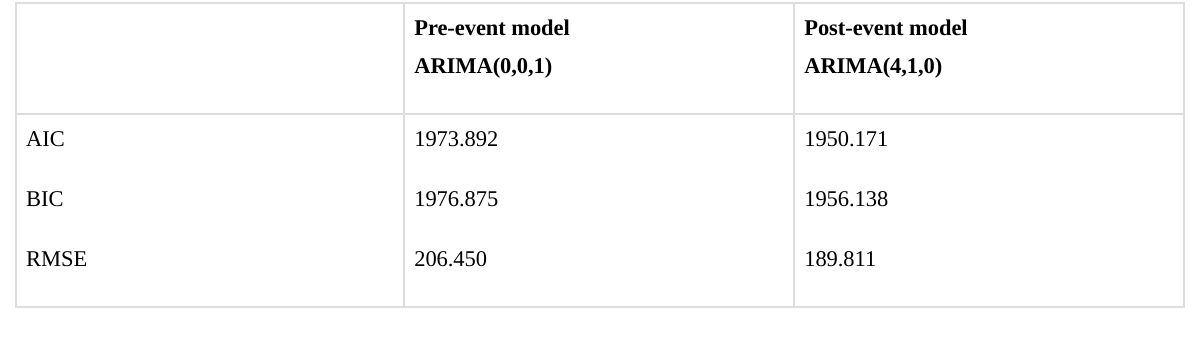
Table A3b. Goodness of fit measures of ARIMA models for miracle cure.